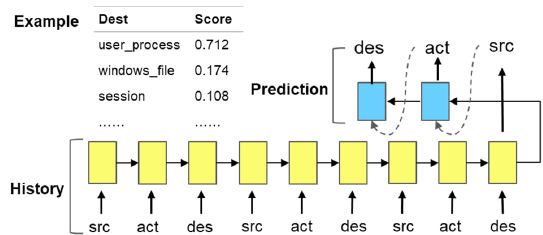
Figure 6. Attack predictive analytics.